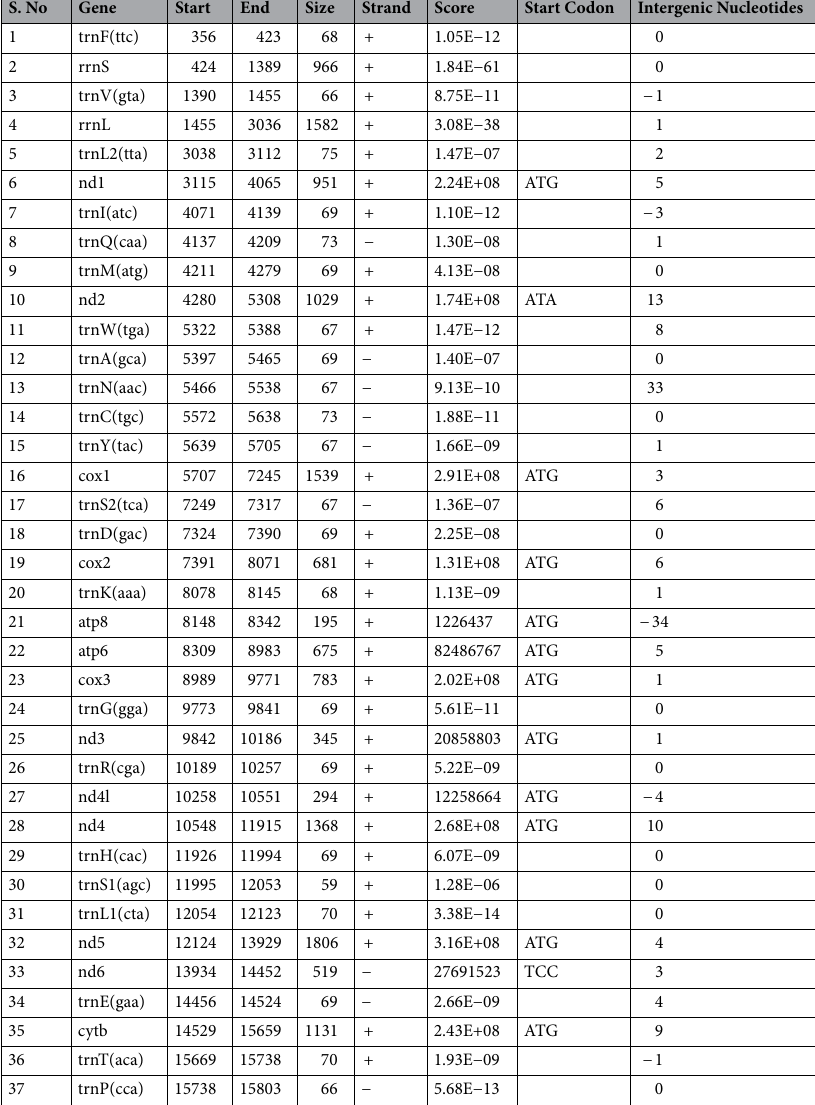
U.t. laniger Table 2. Nucleotide composition and skewness in the Himalayan black bear, Ursus thibetanus laniger mitochondrial genome.